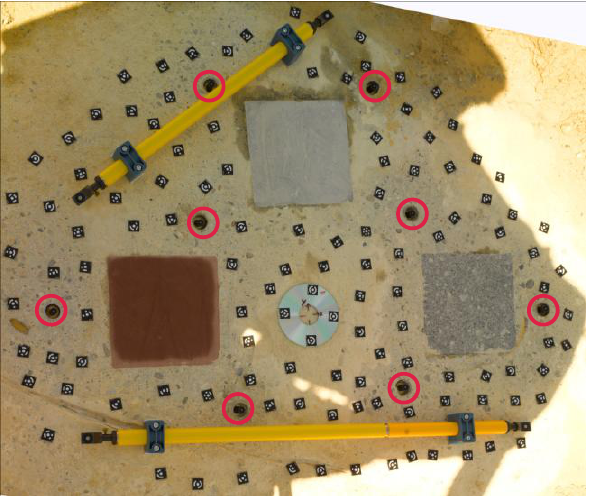
Figure 3. Photogrammetric setup for surveying of the targets at the Illgraben field site. Eight FTI target holders were embedded in the concrete (locations marked in red).